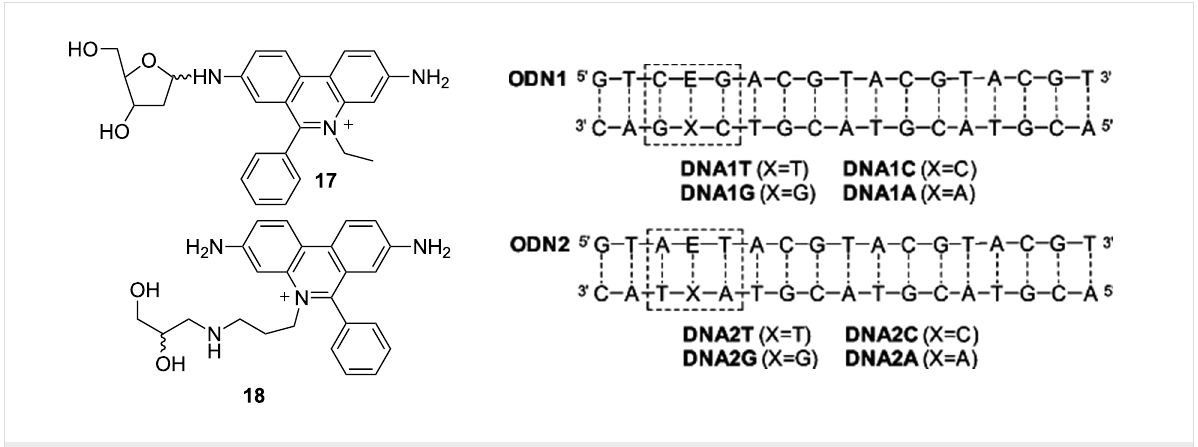
Figure 9: The ethidium bromide nucleosides 17 (top) and 18 (bottom). DNA duplex set 1 and 2 (E = phenanthridinium intercalation site). Reproduced with permission from [87]. Copyright 2004 American Chemical Society.